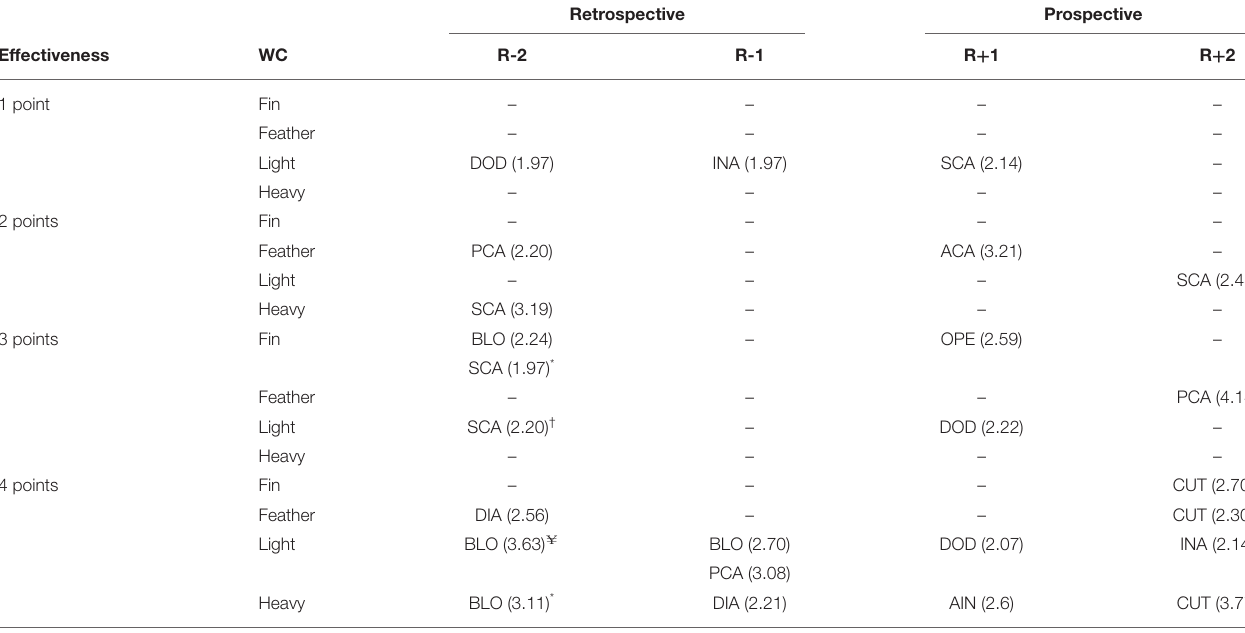
TABLE 4 | Positive relationships between tactical actions and effectiveness in retrospective and prospective perspective for